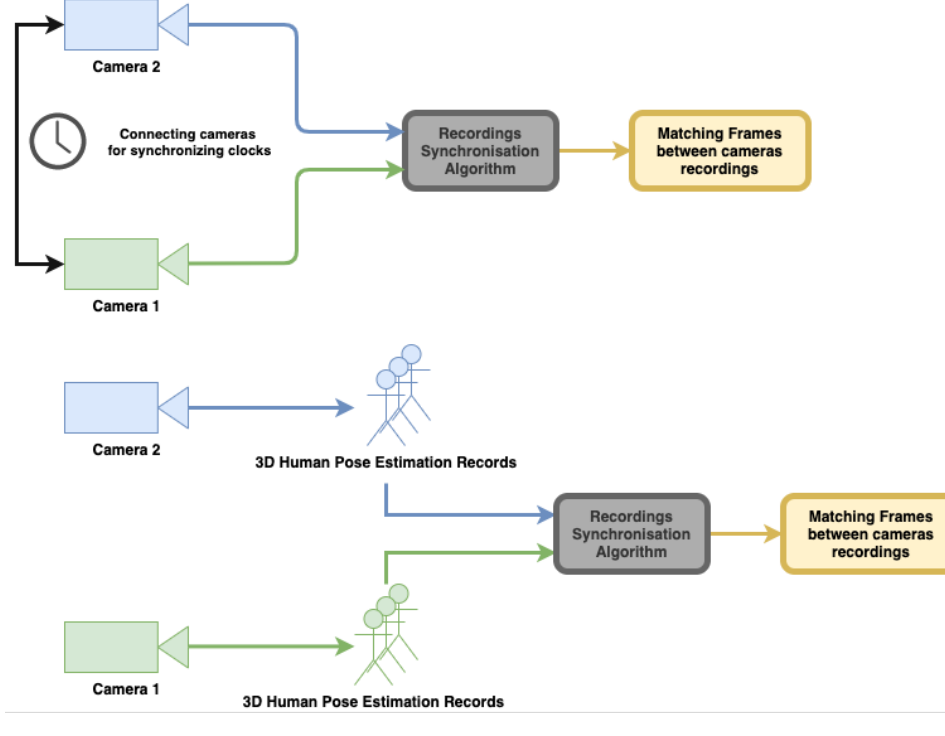
Figure 9. Comparing synchronization methods–Microsoft Azure method using a cable ( top ) vs. our human-motion based method ( bottom